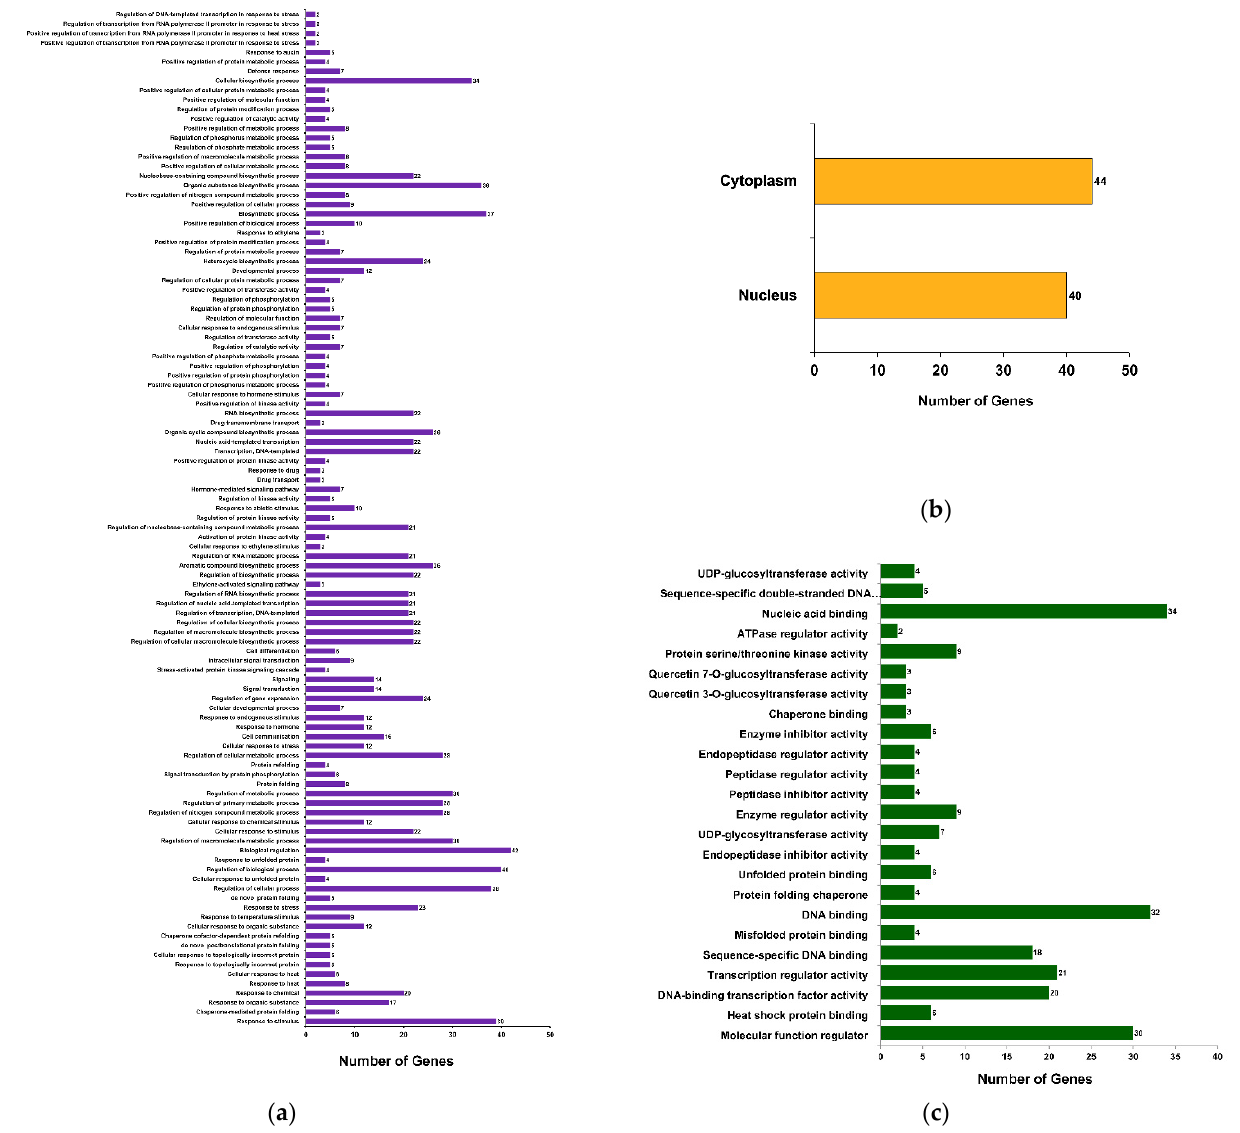
Figure 3. Functional classification of DEGs based on gene ontology (GO). DEGs are annotated with different GO terms and categorized into 133 functional groups. Among these, ( a ) 107 groups are categorized under GO category biological process (GOBP), ( b ) two are under GO category cellular component (GOCC), and ( c ) 24 groups are categorized under GO category molecular function (GOMF).